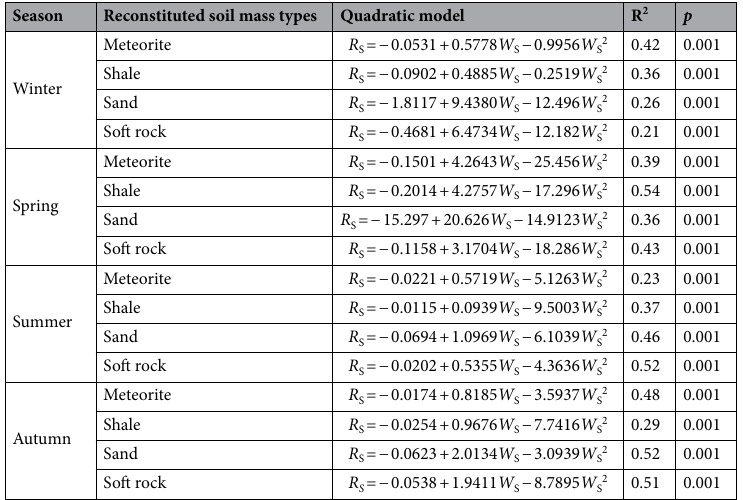
Table 3. Relationship between soil respiration and volumetric water content for reconstituted